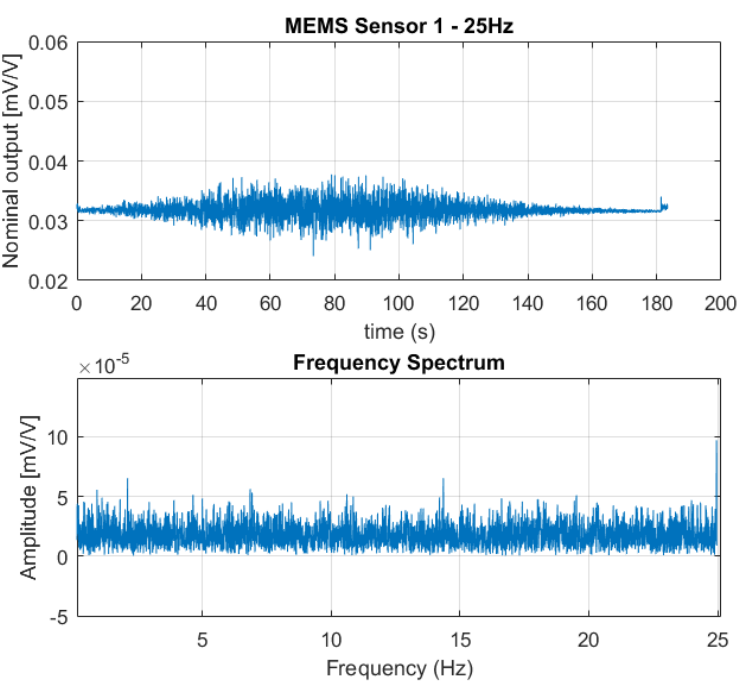
Figure 8. The output signal from one of the sensors in the MEMS-based sensor system as a response to the 25 Hz excitation vibration ( above ) together with the fast Fourier transform of the data set ( below ). The fast Fourier transform indicates the fundamental excitation frequency at 25 Hz, with an amplitude well above the noise floor. As the sampling frequency of the SDL is 50 Hz, we only have data points from the fast Fourier transform up to 25